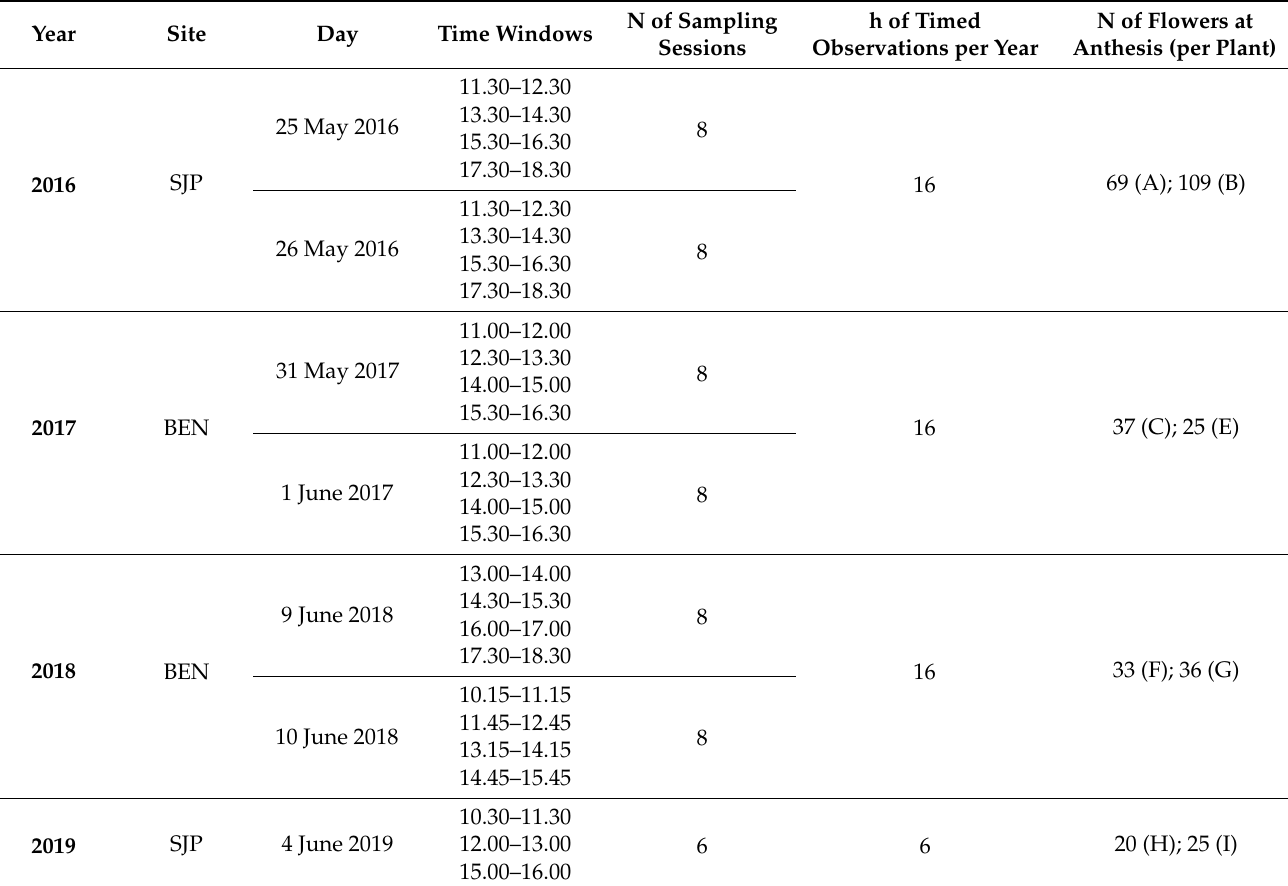
Table 1. Flower-visiting arthropod sampling by timed observations. Year, site, day, time windows, number (N) of sampling sessions, hours (h) of timed observations per year, and number (N) of flowers at anthesis present per plant (letters indicate the identity of the plant) are